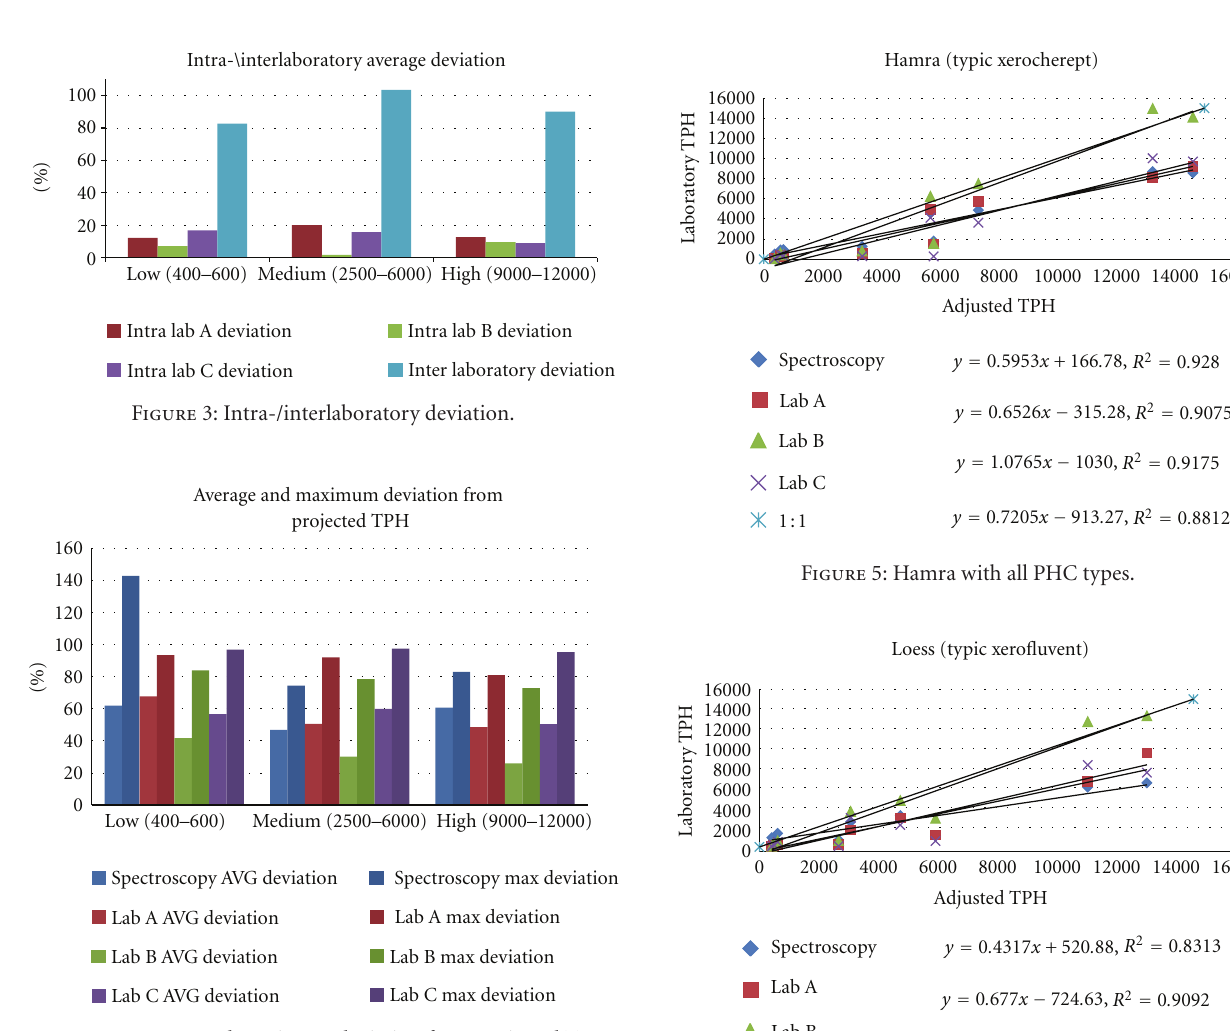
Figure 4: Average and maximum deviation from projected TPH.